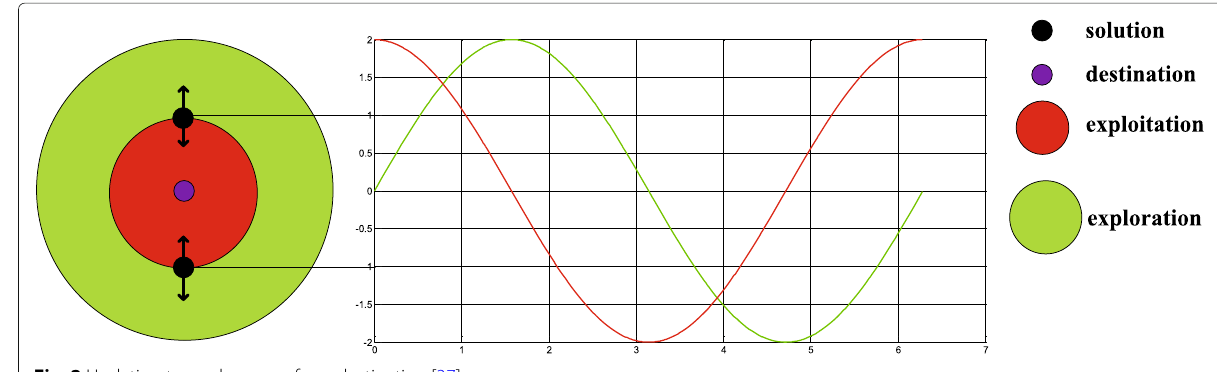
[ 0, 1] . r 1 , r 2 , and r 3 are random numbers. r 4 is a random number in [0,1], and || indicates the absolute value. Basic principle of SCA is represented in Fig. 2.